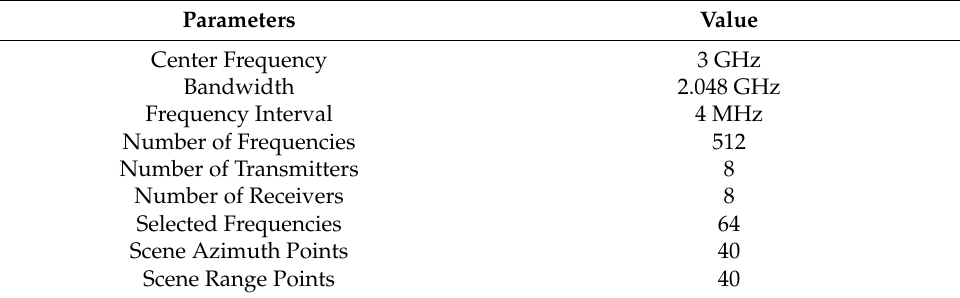
Table 3. Simulation parameters.